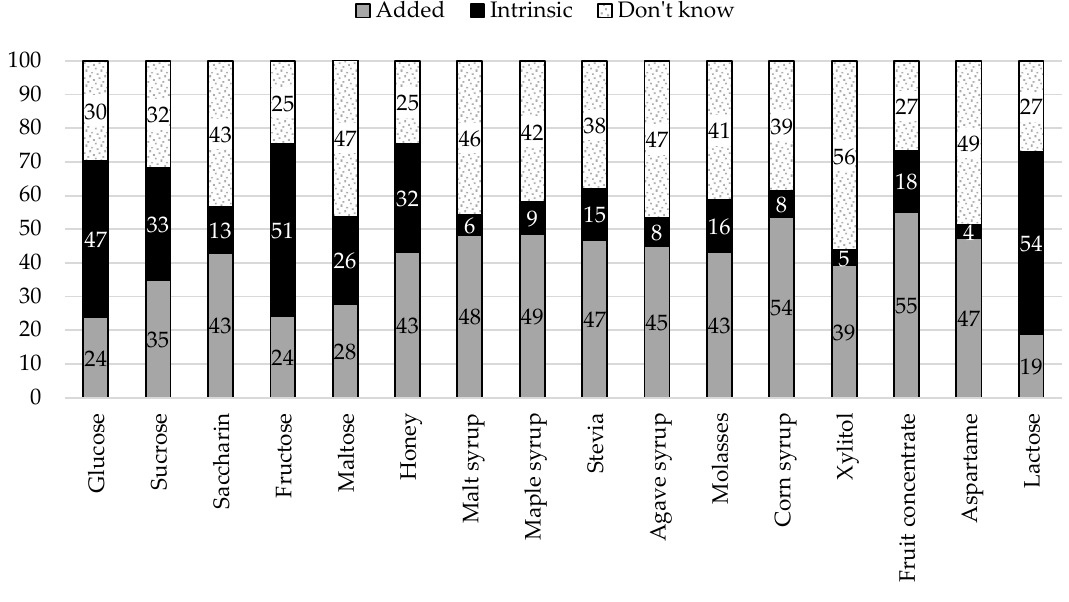
Figure 3. Categorization of sugar sources according to composition.